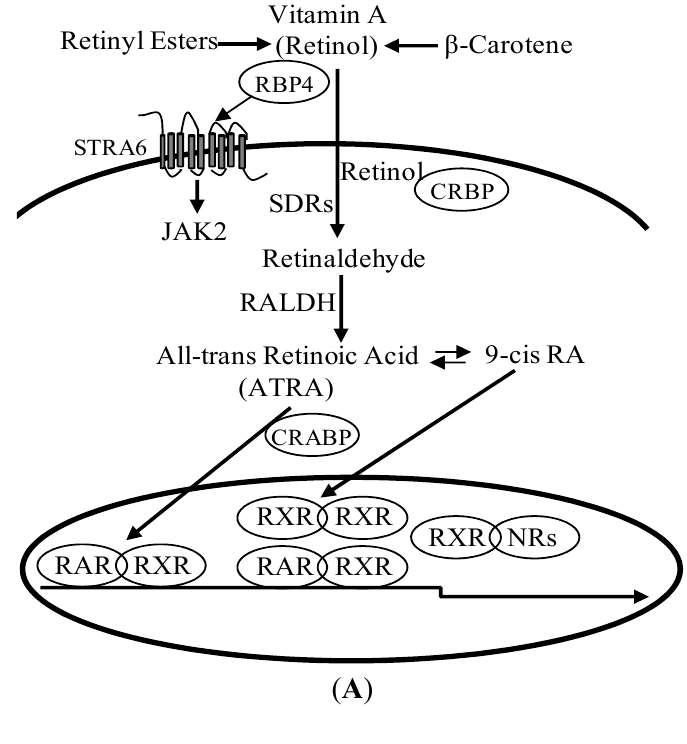
Figure 2. Retinoid metabolism and the structure of retinoid receptors. ( A ) Retinol binds to RBP4 (retinol binding protein 4) in plasma. RBP4 bonds to STRA6, resulting in the activation of the JAK2 signaling pathway. Retinol bound with cellular retinol-binding protein (CRBP) is converted to retinaldehyde by short-chain dehydrogenase/reductase (SDR); and then to all- trans retinoic acid (ATRA) by retinaldehyde dehydrogenase (RALDH); ( B ) Schematic representation of the functional domains and the major phosphorylation sites of RAR α (retinoic acid receptor α ) and RXR α (retinoid X receptors α ). The DNA-binding domain (DBD) and the ligand-binding domain (LBD) are schematically represented (not to scale). The functional AF-1 and AF-2 domains lie in the A/B and E regions, respectively. Phosphorylation sites are shown in a bold black line. Vitamin A Retinyl Esters